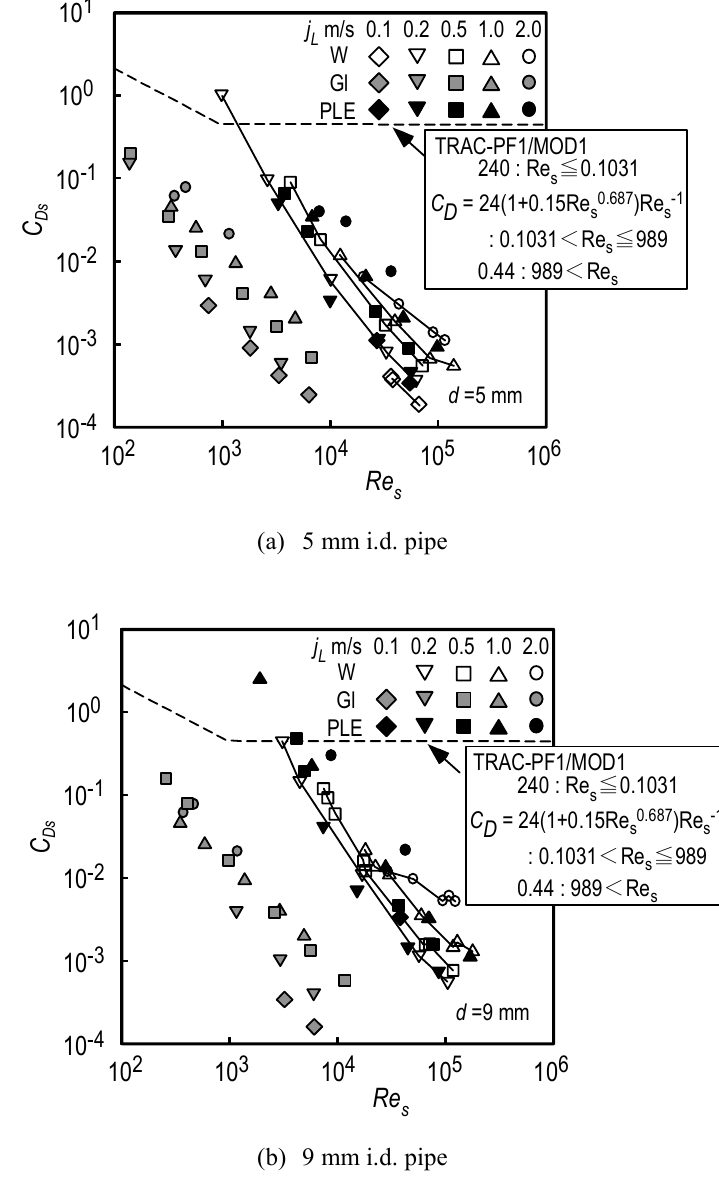
Fig. 2 Drag coefficients of large bubbles for slug